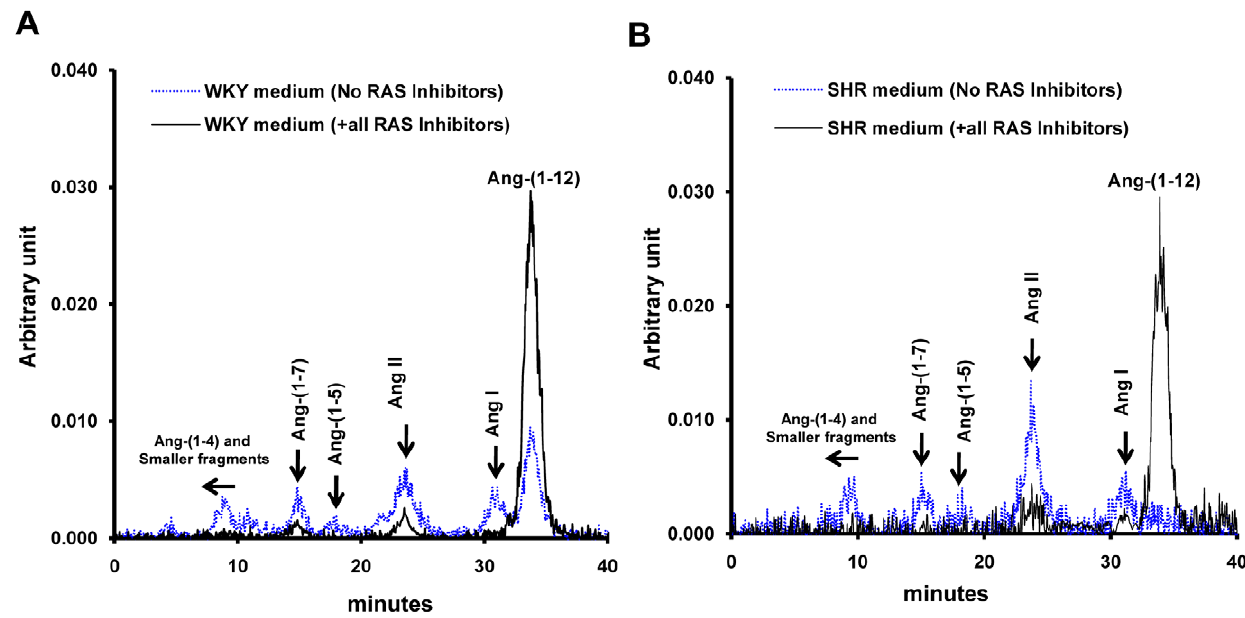
Figure 3. Patterns of Ang-(1–12) metabolism in the medium collected from cardiac myocytes. HPLC characterization of 125 I-Ang products generated in the medium of cultured neonatal WKY (A) and SHR (B) cardiac myocytes exposed to 125 I-Ang-(1–12) at 37 u C for 60 min in the presence (solid line) and absence (dotted line) of the RAS inhibitors cocktail. Other conditions as described in Figure 2. doi:10.1371/journal.pone.0015759.g003 serum deprived neonatal cultured SHR myocytes as compared to (Figure 6). After correcting the angiotensinogen protein expres- WKY. Renin expression in these samples was also analyzed by sion level with loading control (EF-1 a ), we observed a tendency using a well-characterized renin antibody obtained from Dr. for a decreased level of angiotensinogen protein in 48 hours Table 1. Comparative effects of selective enzyme inhibition on 125 I-Ang-(1–12) metabolism in medium of cultured neonatal wky and shr cardiac